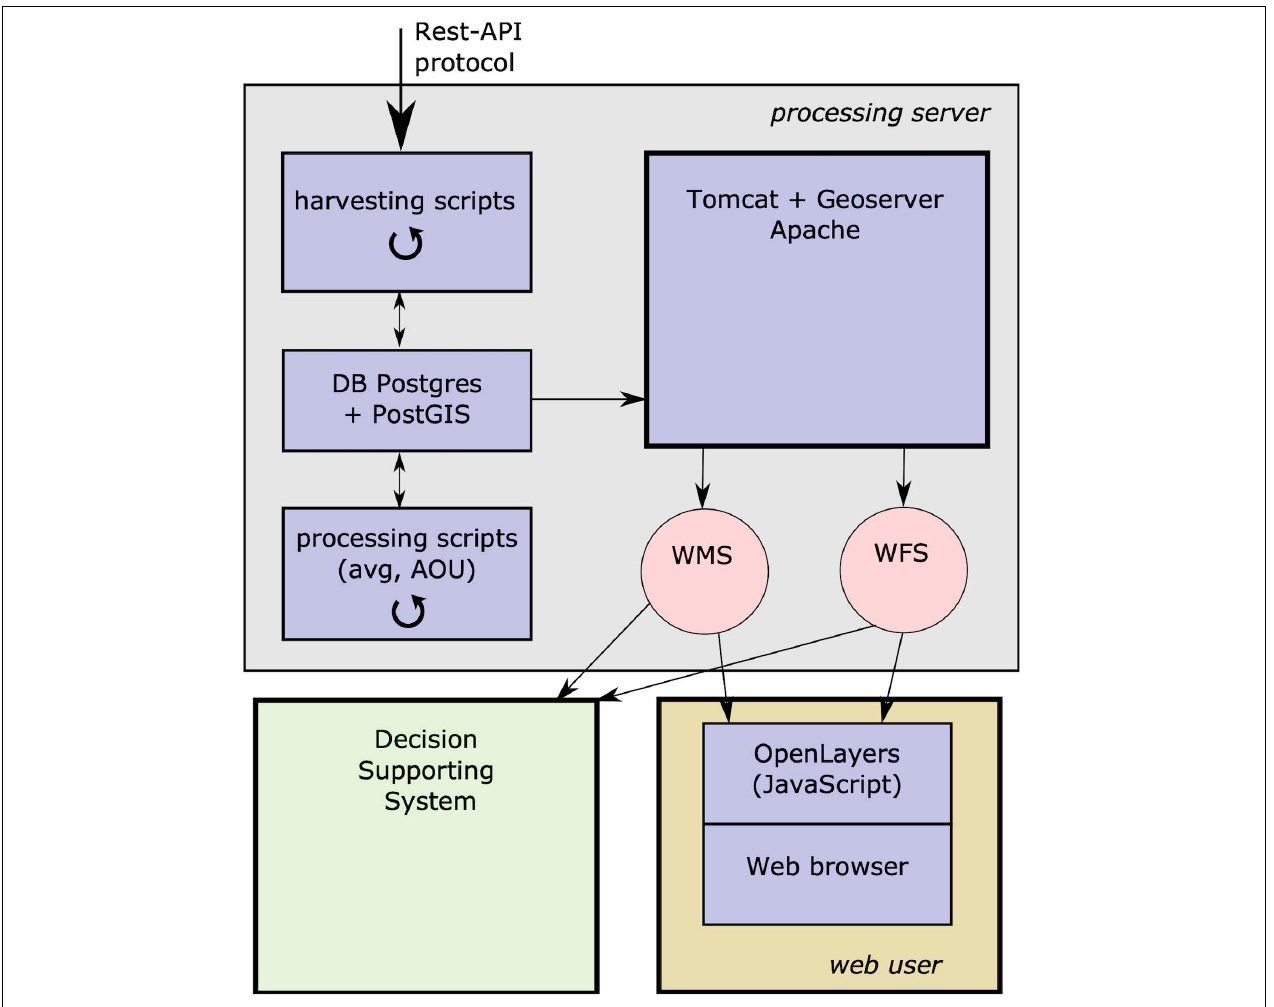
FIGURE 8 | Architecture of the MaDCrow processing server and the web